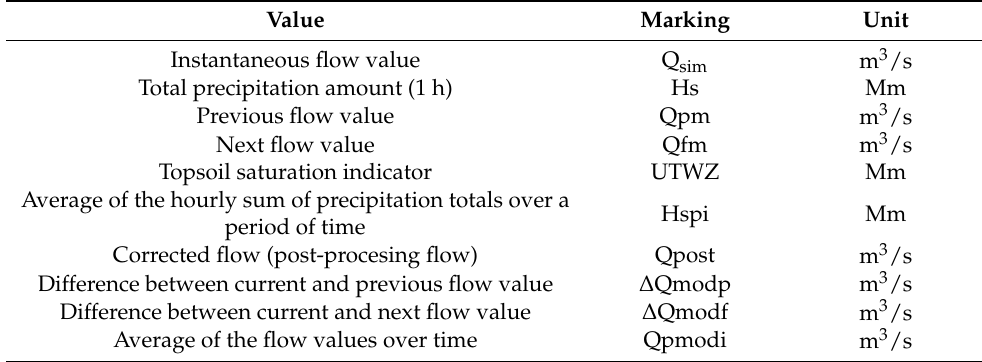
Figure 3. Model scheme without using sequential aggregation of inputs.